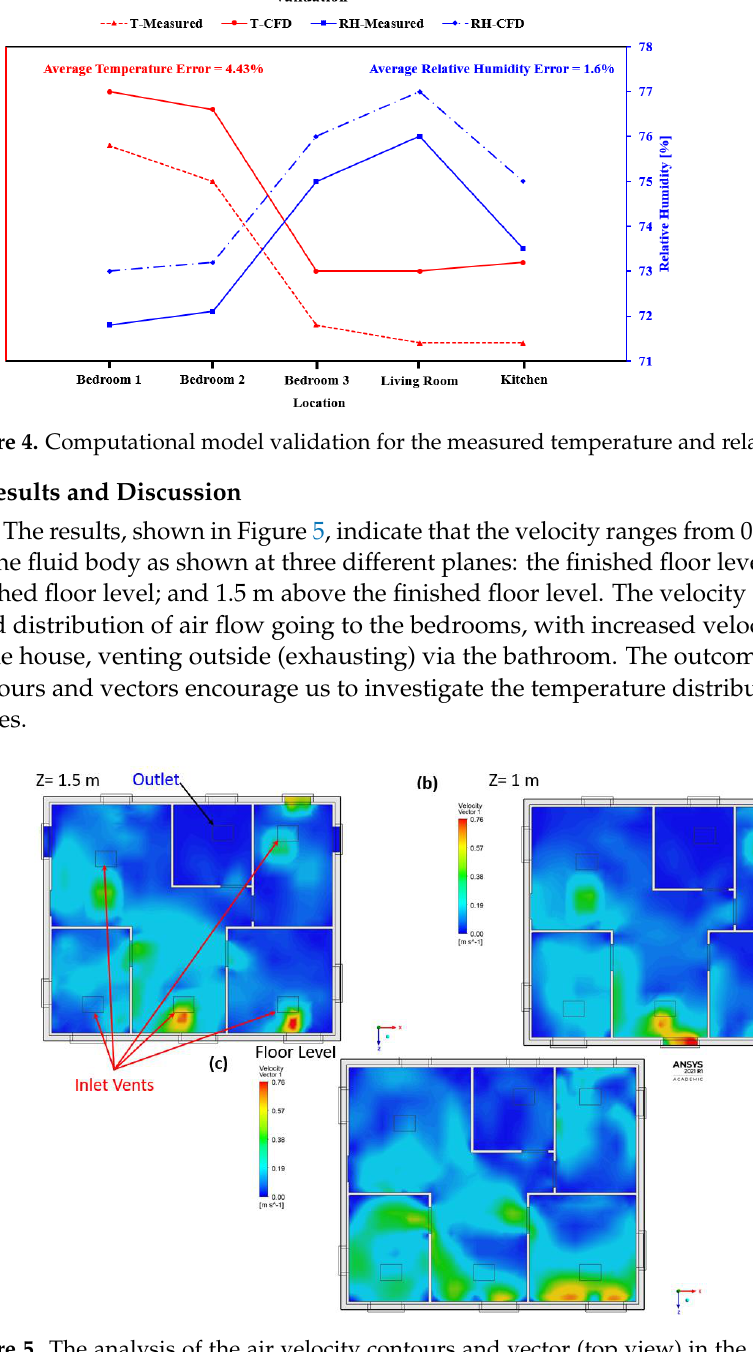
Figure 5. The analysis of the air velocity contours and vector (top view) in the house at different height ( a ) 1.5 m, ( b ) 1 m and ( c ) (finished) floor level.